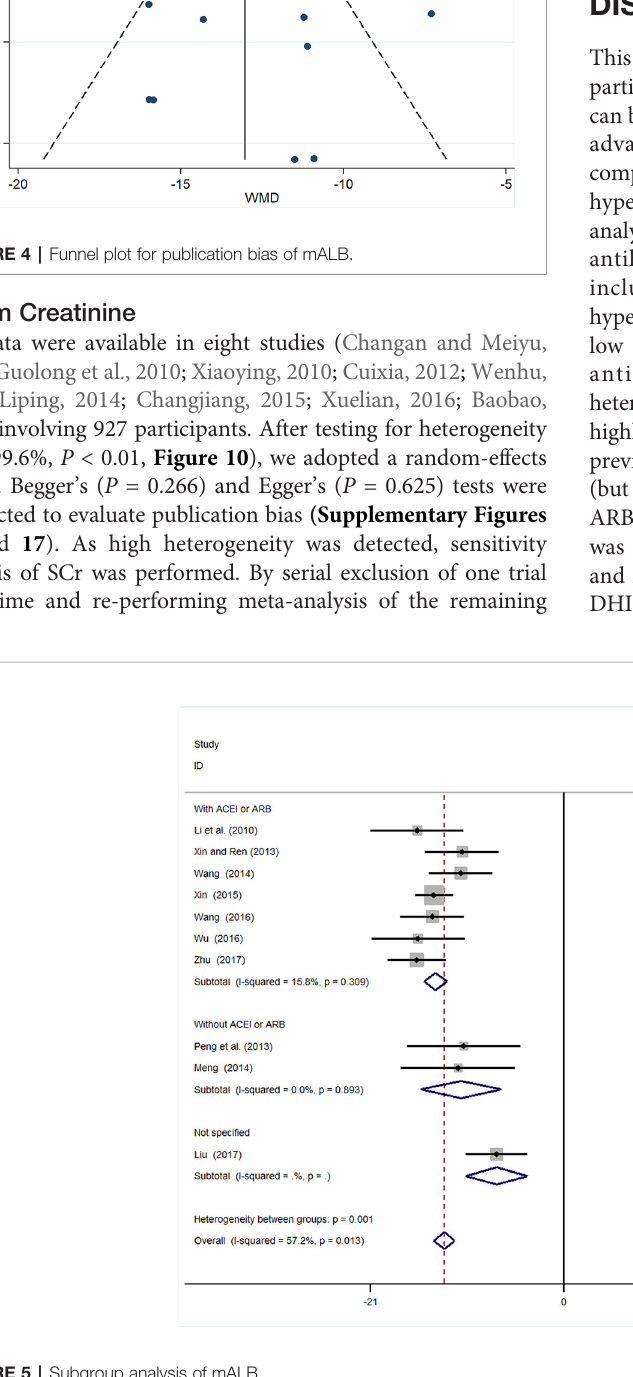
FIGURE 5 | Subgroup analysis of